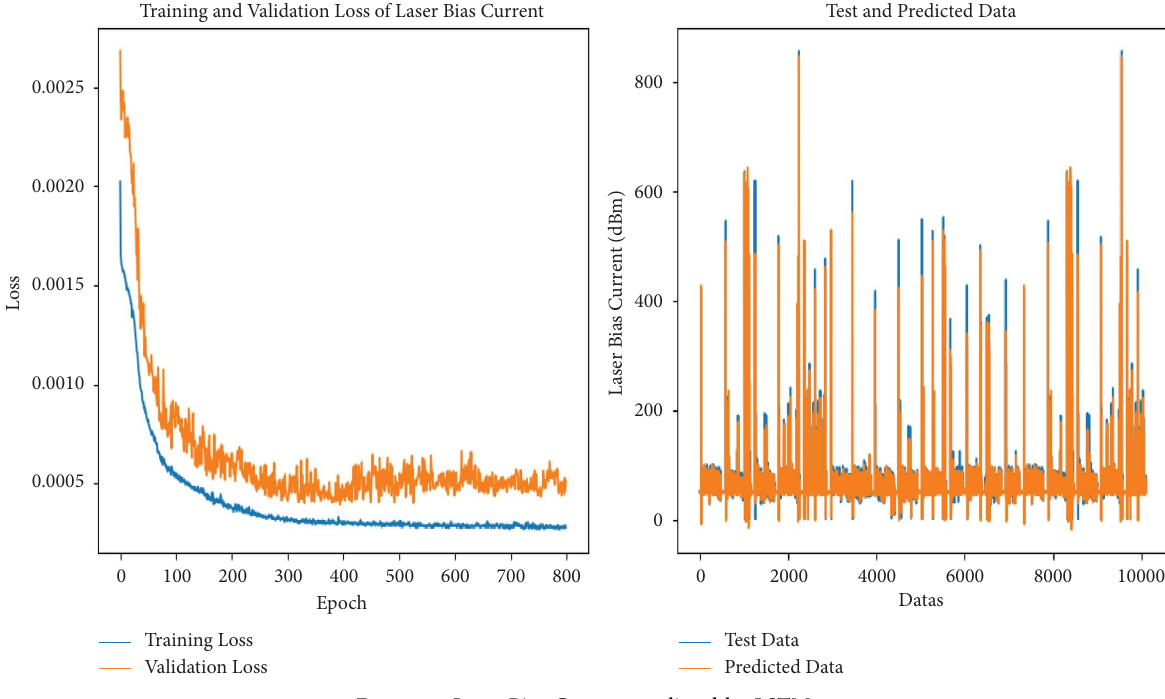
Figure 5: Laser Bias Current predicted by LSTM.